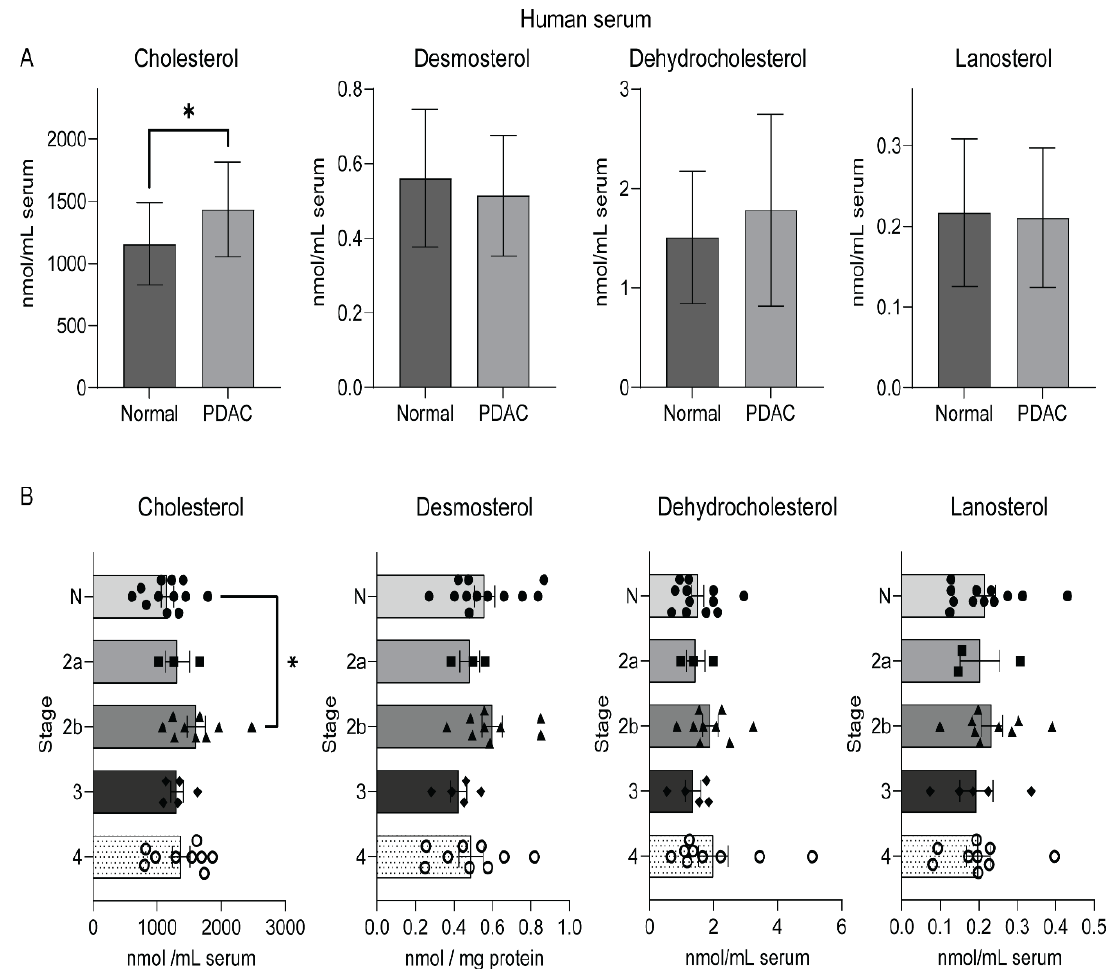
Figure 3. Serum cholesterol levels are high in human pancreatic cancer. ( A ) Mean and standard deviation plots showing sterol levels in human sera collected from healthy (normal) and patients with pancreatic ductal adenocarcinoma (PDAC) normalized with the volume of the specimen. ( B ) Mean and SE plots showing sterol levels in human normalized to serum volume and classified based on healthy (normal) and stagewise progression of pancreatic cancer, including stages 2a, 2b, 3, and 4, respectively. * indicates p < 0.05 obtained through unpaired t- test.